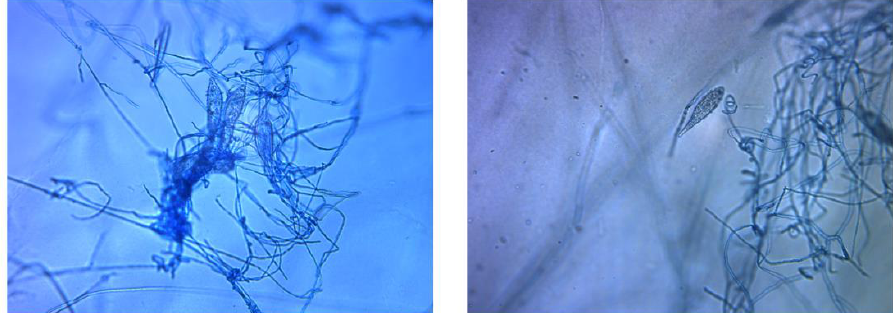
Figure 4. Microscopic morphological features of Microsporum audouinii. Spindle-shaped, septate macroconidia with echinulate surface (magnification x200).